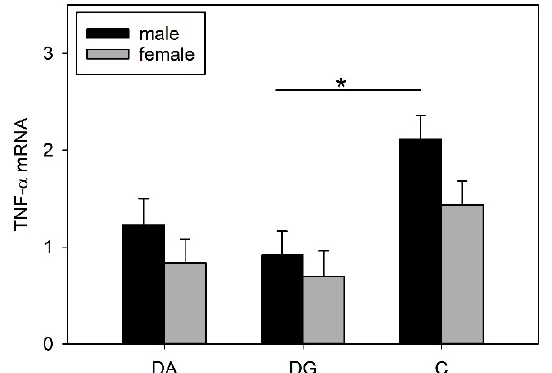
Figure 4. Hypothalamic TNF- α mRNA expression of DA (deprivation alone), DG (deprivation with a group of littermates) and C (control, no deprivation) piglets 24 h after LPS application. Data are expressed as arbitrary units after normalisation to ACTB and TBP mRNA expression as endogenous reference genes and represent the LS means ± SE. Significant di ff erences are indicated by asterisks (* p < 0.05; n = 7 pigs per treatment group and